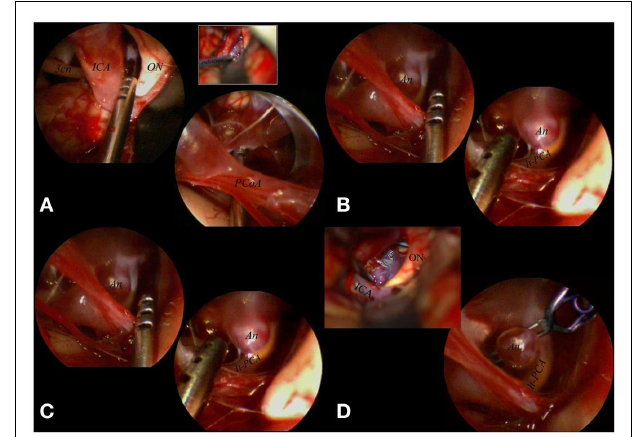
FIGURE 3 |The aneurysm was mobilized, under scopic control, with the microsucker passing beyond and behind the PCoA (A) .With the sucker introduced below and in front of the PCoA the aneurysmal sac and the surrounding circulation were exposed (B) .The aneurysm was clipped passing with the clip applier in the corridor between ON and ICA, with the scope fixed to a mechanical holder to control the surgical maneuvers (comparing the microsurgical and the endoscopic views it is clear that the endoscope better visualized the distal portion of the clip (C) .The final endoscopic control allowed to confirm patency of the left PCA not clearly visible under the microscope (D) . 3cn, oculomotor nerve; An, aneurysm; ICA, internal carotid artery; lt, left; ON, optic nerve; PCA, posterior cerebral artery; PCoA, posterior communicating